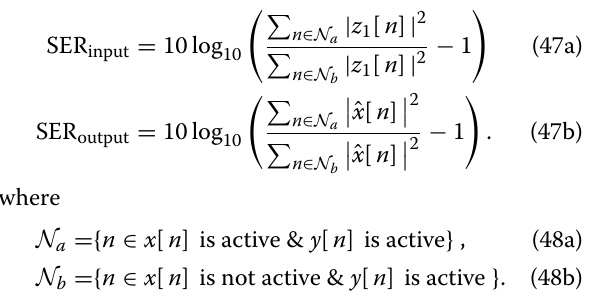
Table 2 Results of speech quality, intelligibility and dereverberation measures for Scenario #2. The input signal refers to one of the microphones. NLMS refers to applying NLMS alone with any dereverberation algorithm. The values of LSD, SRMR and SER are in dB and the values of the STOI measure are